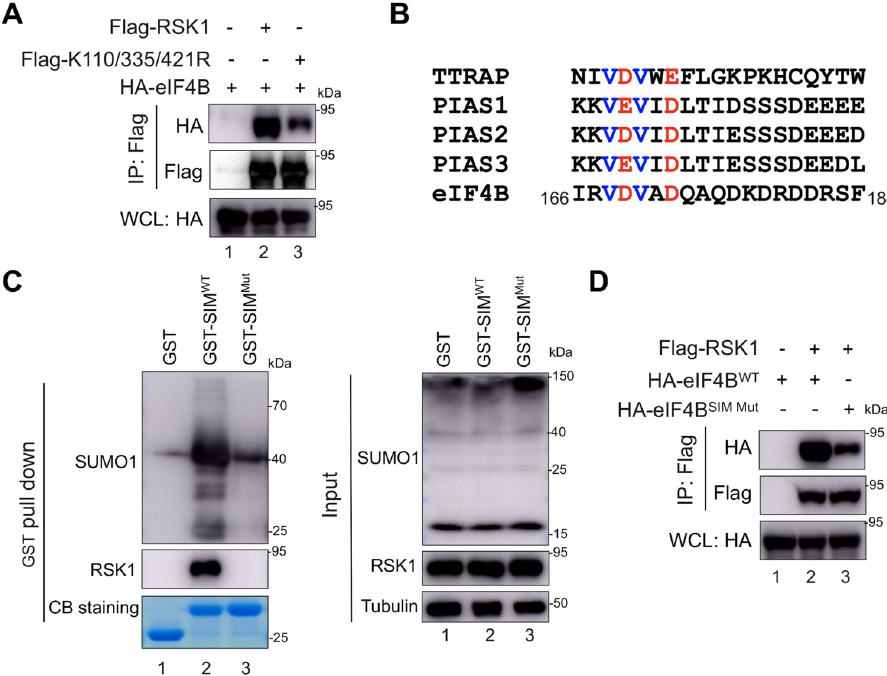
Fig 6. SUMO-SIM interaction contributes to RSK1-eIF4B association. ( A ) SUMOylation of RSK1 is required for efficient interaction between RSK1 and eIF4B. HEK293T cells were co-transfected with indicated plasmids and cell lysates were subjected to IP and IB with indicated antibodies at 48 h post-transfection. ( B ) Alignment of SIMs among eIF4B, PIAS1, PIAS2, PIAS3, and TTRAP. ( C ) eIF4B SIM binds to endogenous SUMO1 and RSK1. GST vector control and GST-tagged eIF4B SIM or its mutant were purified from E . coli and subjected to GST pull-down assay with HEK293T cell lysates. The co-precipitated proteins were analyzed by IB with indicated antibodies. ( D ) SIM mutation within eIF4B reduced the RSK1-eIF4B association. HEK293T cells were co-transfected with indicated plasmids and cell lysates were subjected to IP and IB with indicated antibodies at 48 h post-transfection.